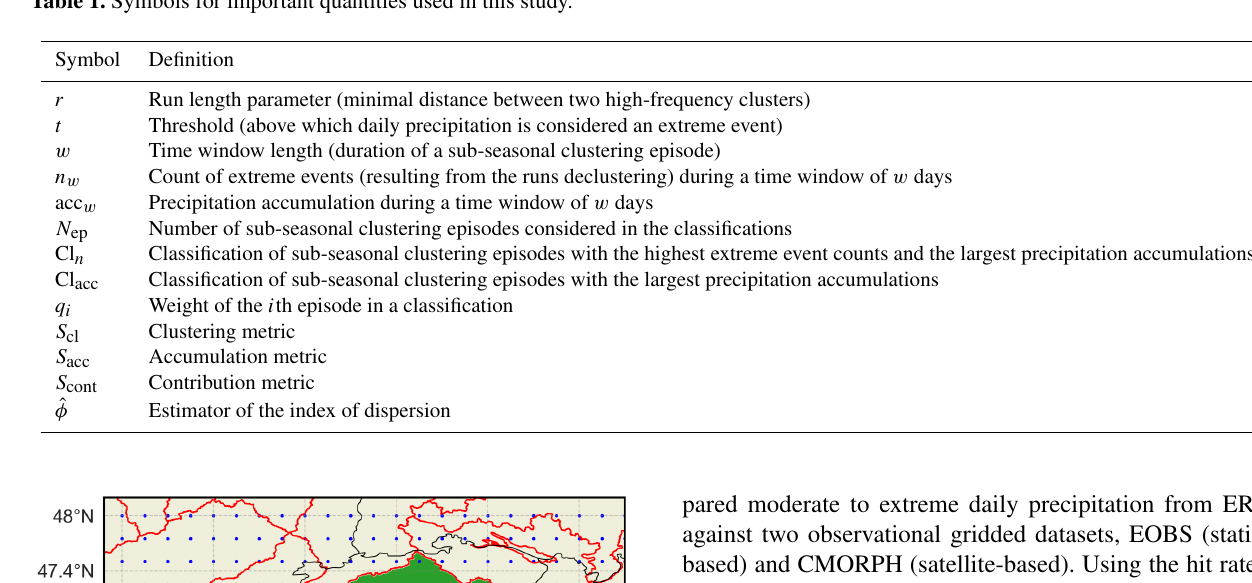
Table 1. Symbols for important quantities used in this study.